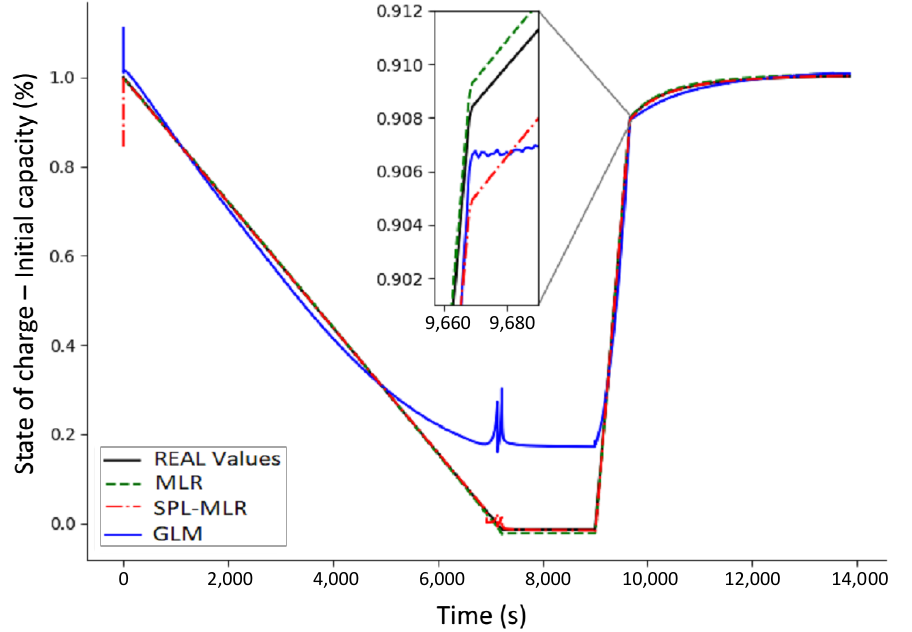
Figure 5. Initial Capacity Curve for DE